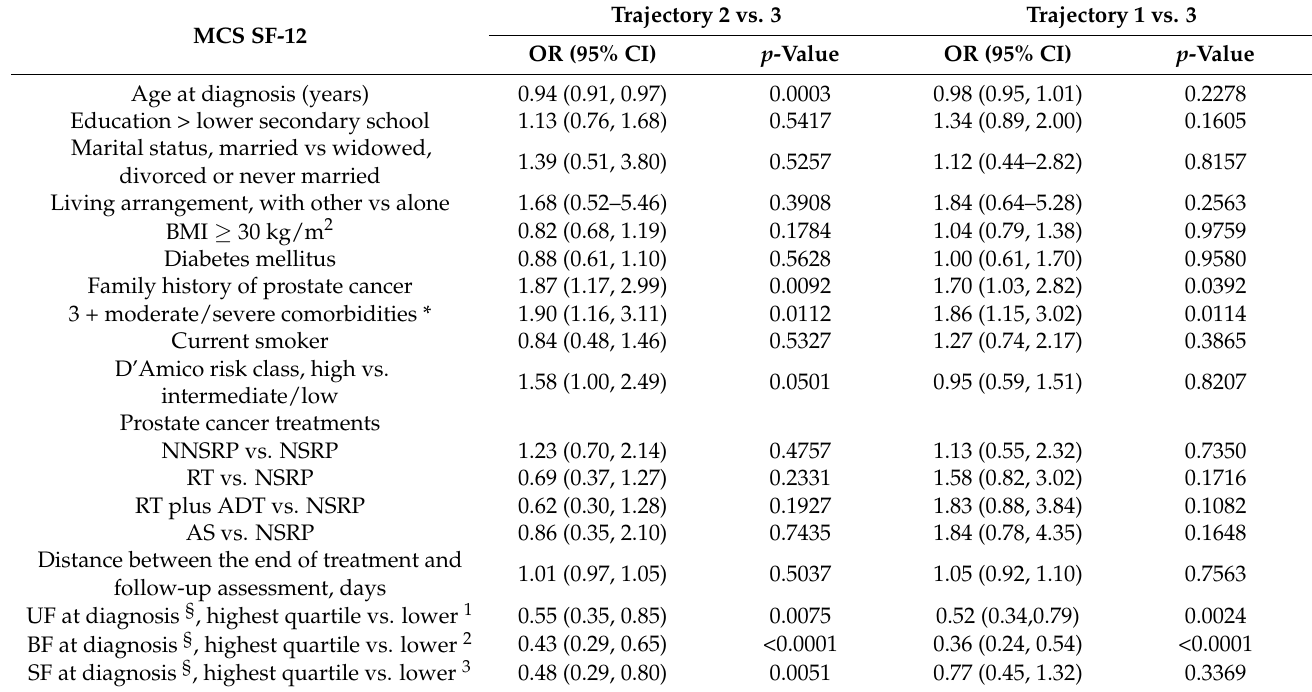
Table 2. Predictors of the trajectory class membership for the Mental Composite Score